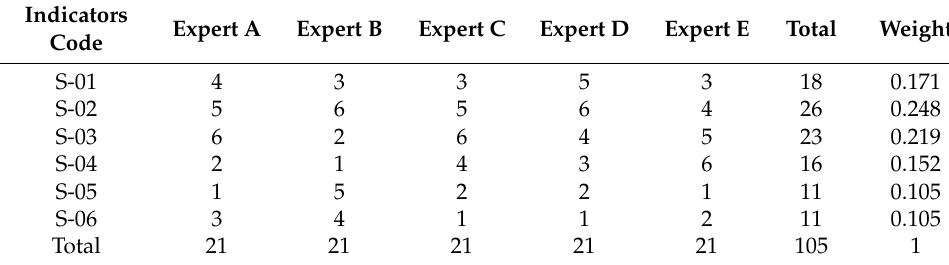
Table 6. The weight of SFS’s Information Quality.